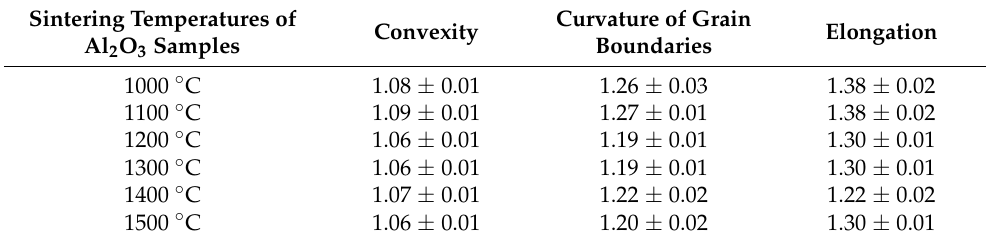
Table 3. The parameters characterizing the shape factors of alumina grains in all samples. Sintering Temperatures of